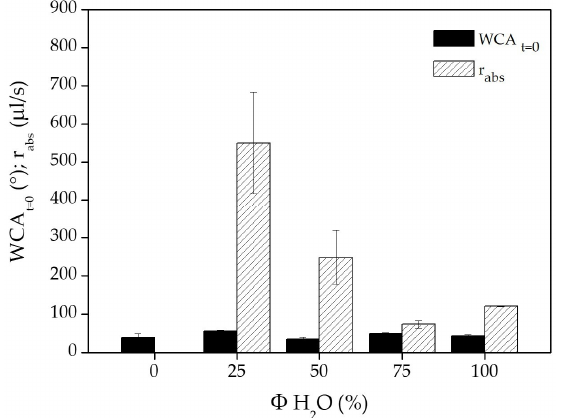
Figure 6. Water absorption rate and WCA values at absorption time zero for PCL scaffolds treated with Ar, Ar/H 2 O, or H 2 O feed as a function of the feed